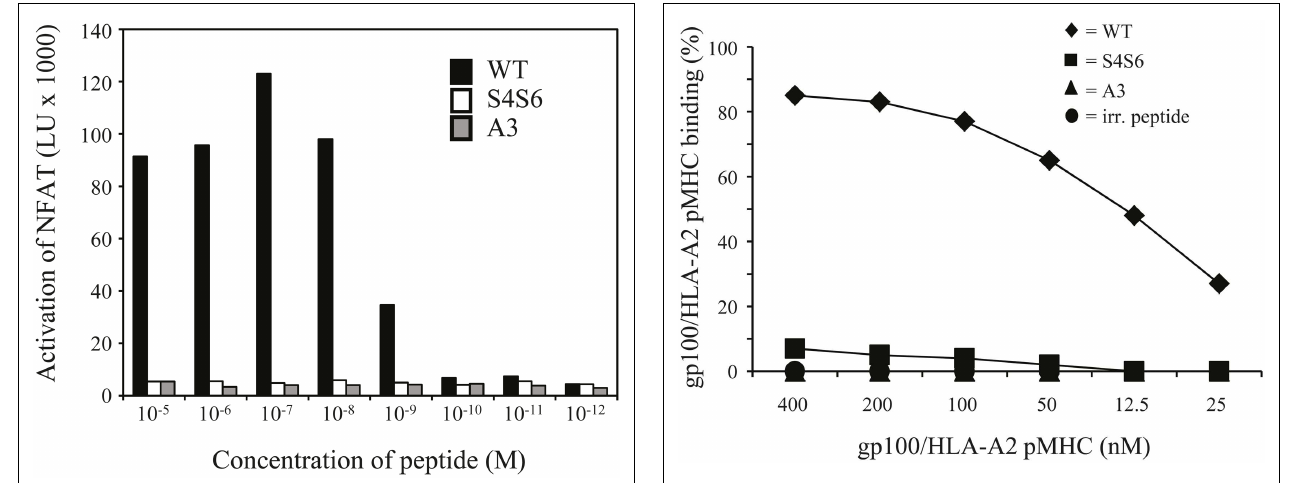
FIGURE 6 | DifferentialT cell responsiveness toward gp100APLs is related toTCR’s ability to bind gp100/HLA-A2 complexes . TCR-engineeredT cells were stained with titrated amounts of PE-conjugated peptide-MHC multimers (range: 400–12,5nM peptide-MHC complexes) and analyzed via flow cytometry.The gp100-HLA-A2 multimers comprise either gp100 wt peptide or APLs A3 and S4S6.The BMLF-1-HLA-A2 multimer served as a negative control. Binding of peptide-MHC multimers is analyzed as described in Section “Flow Cytometry and Cell-Sorting” and indicated in percentage. Percentages correspond to marker-positiveT cells. Results of one (out of two) representative experiment are shown based on the mean value of triplicate data points.